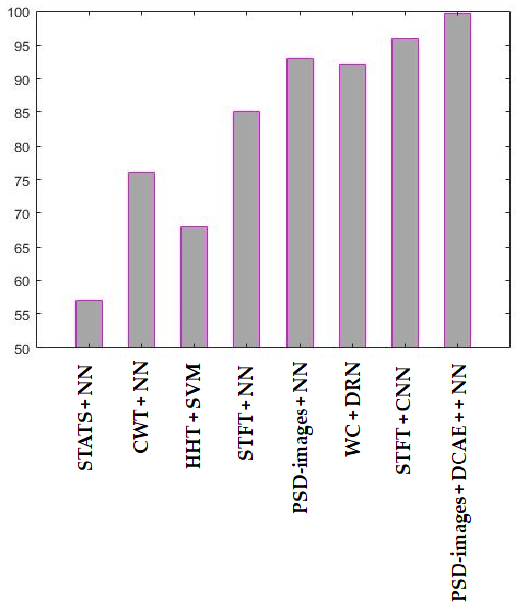
Figure 21. Results of the different approaches used during the experiments. NN: neural network; SVM: support vector machine.